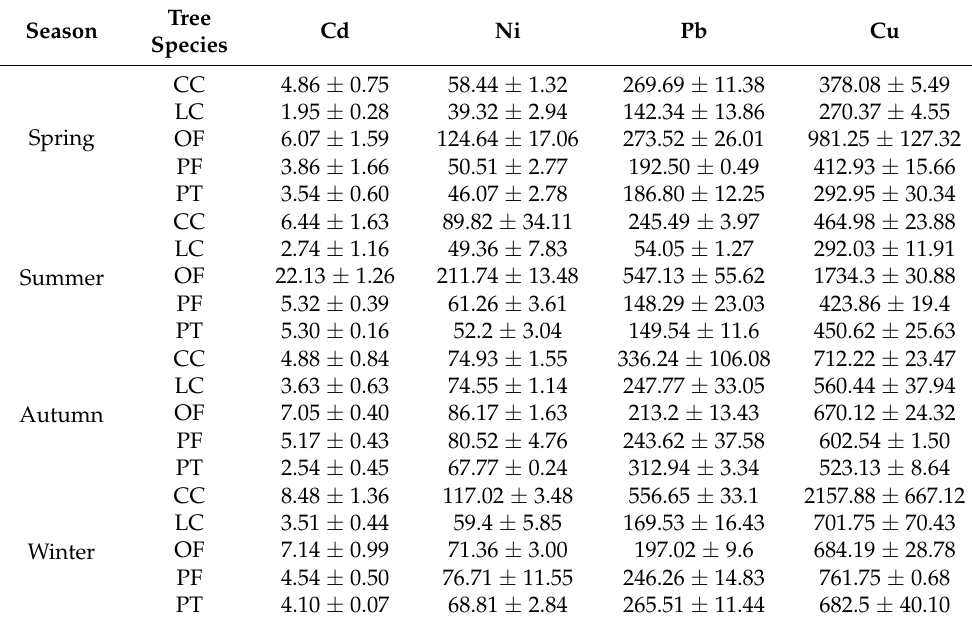
Table 1. Metal content in leaf particulate matter (mg · kg -1 ).